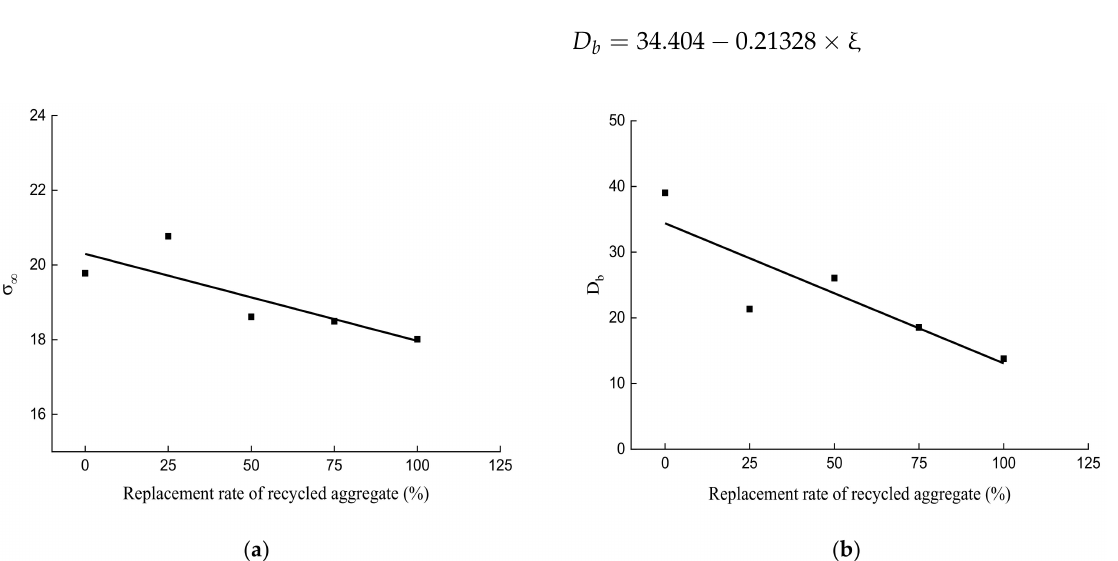
Figure 11. The correlation between the substitution ratio of recycled aggregate and the different parameters: ( a ) parameter σ ∞ ; and ( b ) parameter D b